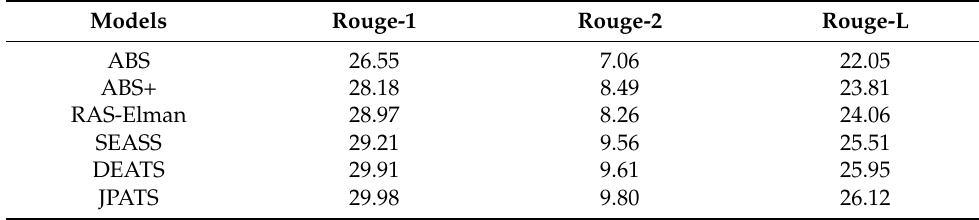
Table 3. Rouge scores of JPATS on dataset DUC 2004.